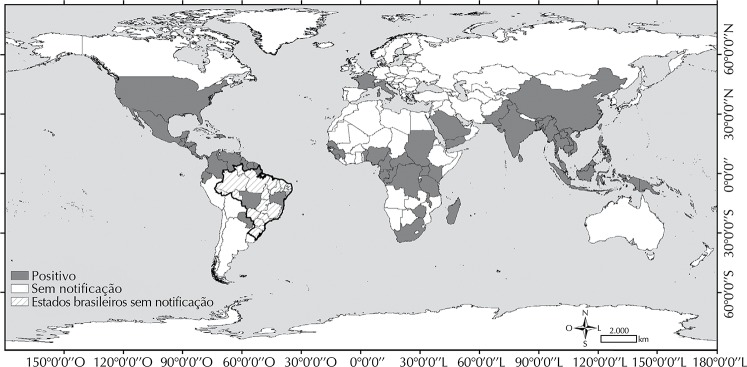
Áreas com transmissão do vírus chikungunya no mundo.